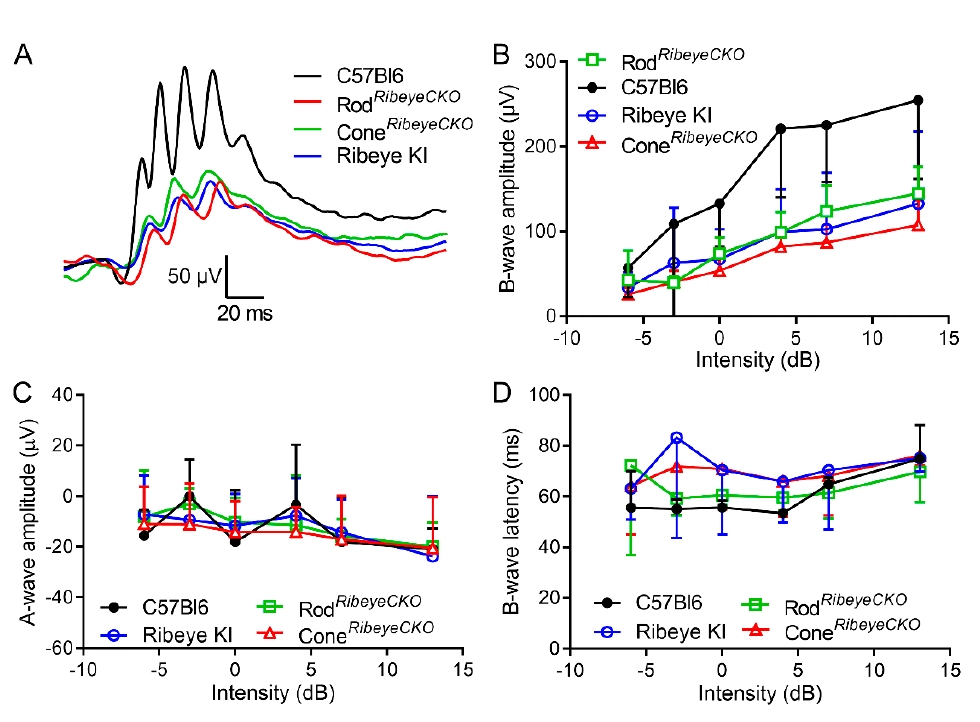
Figure 6. Photopic ERG b-waves are reduced equally in cone Ribeye CKO , rod Ribeye CKO , and Ribeye KI retinas. ( A ) Example waveforms. ( B ) B-wave amplitude as a function of flash intensity measured in C57Bl6J ( n = 5 mice), cone Ribeye CKO ( n = 5), rod Ribeye CKO ( n = 5), and Ribeye KI retinas ( n = 4). ( C ) A-wave amplitude as a function of intensity. ( D ) B-wave latency vs. intensity.